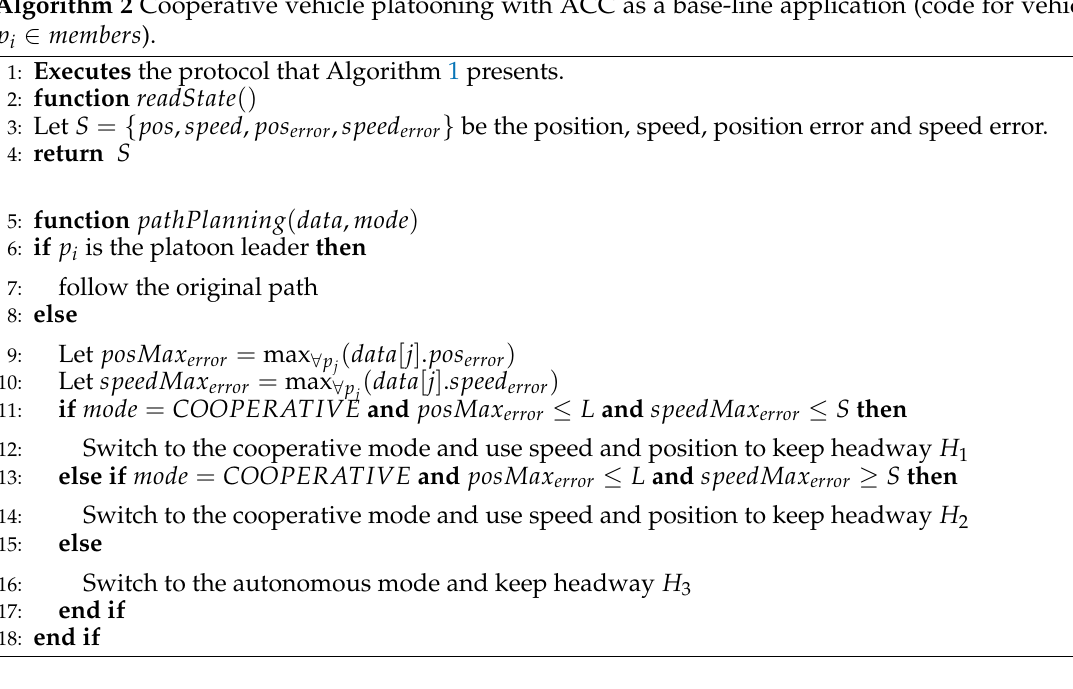
Algorithm 2 Cooperative vehicle platooning with ACC as a base-line application (code for vehicle p i ∈ members